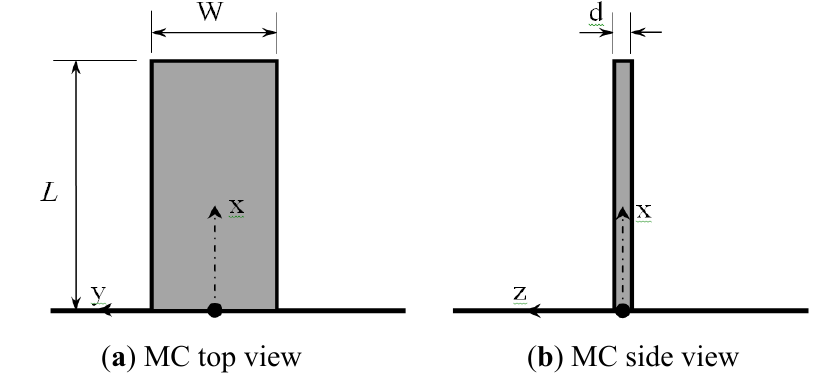
Figure 1. Schematic diagrams and the corresponding coordinate system for typical rectangular microcantliever (MC): ( a ) Top view of rectangular MC; and ( b ) Side view of rectangular